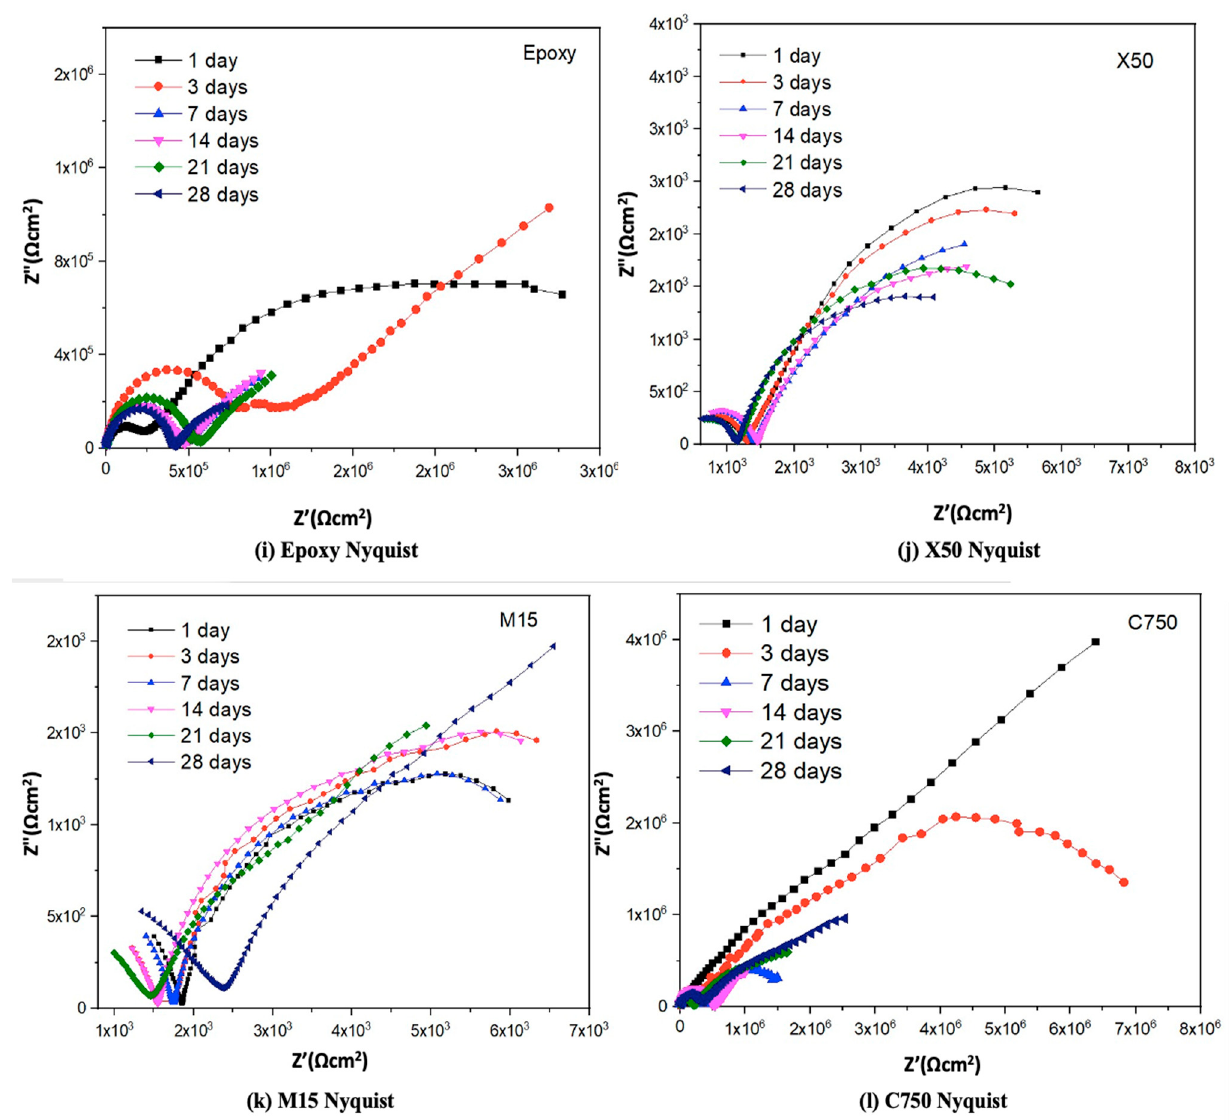
Figure 9. Bode plots of ( a , b ) neat epoxy, ( c , d ) X50 Gnp/epoxy, ( e , f ) M15 Gnp/epoxy, and ( g , h ) C750 Gnp/epoxy and Nyquist diagram of ( i ) neat epoxy, ( j ) X50 Gnp/epoxy, ( k ) M15 Gnp/epoxy, ( l ) C750 Gnp/epoxy coatings immersed in 3.5% NaCl solution for different exposure time.